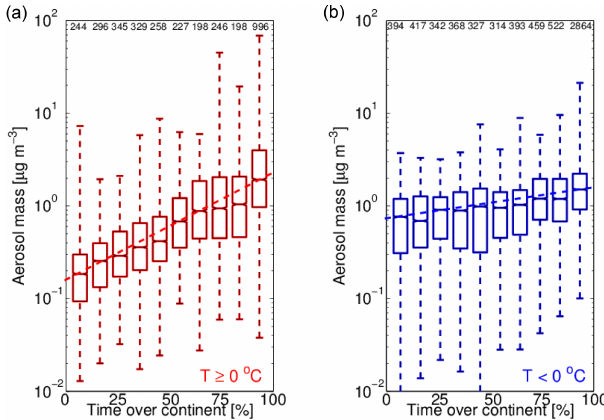
Figure 9. Aerosol total mass ( ≤ 500nm) versus percentage of time the air mass spent over continental areas over the last 120h. Me- dian mass concentration around each back trajectory (for every 3h) was used in calculations. In panel (a) the data measured at tempera- tures ≥ 0 ◦ C are depicted in red, and in panel (b) the data measured at temperatures < 0 ◦ C are shown. Boxes show the quartiles, with whiskers extending to extreme data points. Above each box is the number of cases used in calculations. Dashed red and blue lines are added to guide the